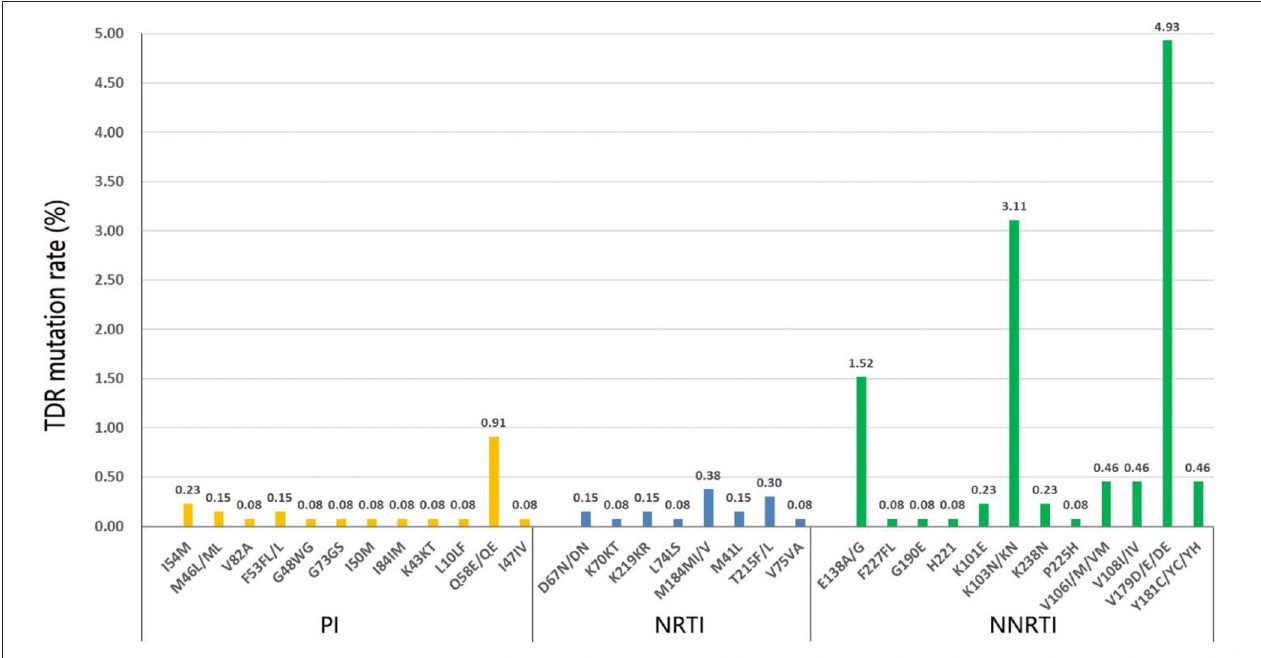
FIGURE 1 | Different HIV-1 transmitted drug resistance (TDR) mutations to PIs, NRTIs, and